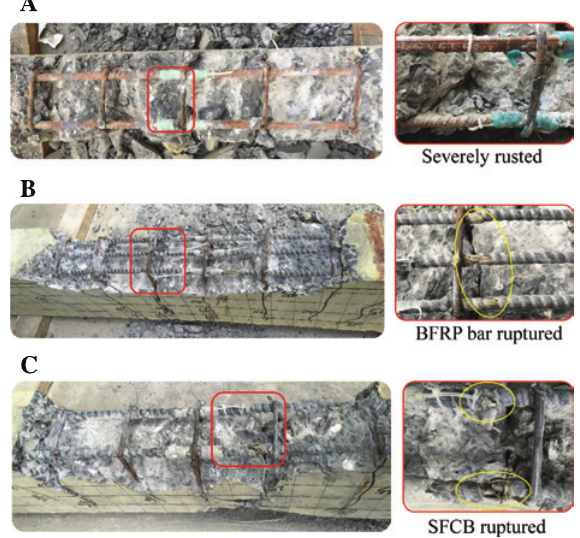
Figure 6: Surface conditions of tension reinforcements of beams after 12 months of exposure. (A) Steel bars RC beam, (B) BFRP bars RC beam and (C) SFCBs RC